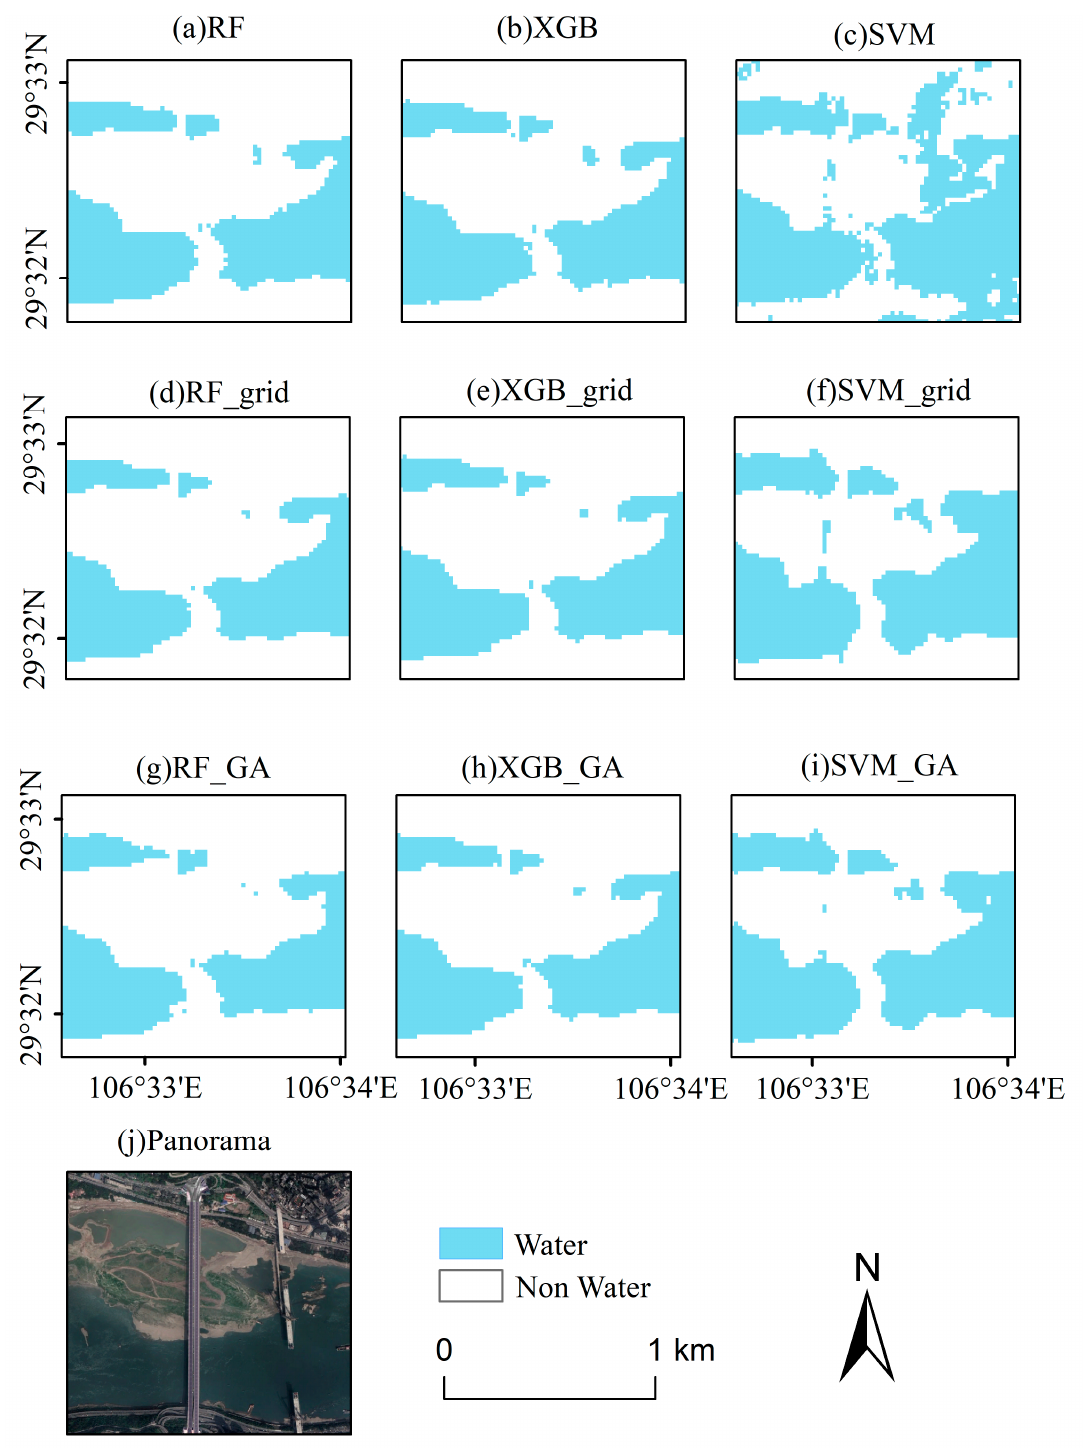
Figure 6. Maps of water surfaces produced by ( a ) RF, ( b ) XGB, ( c ) SVM, ( d ) RF optimized by grid search, ( e ) XGB optimized by grid search, ( f ) SVM optimized by grid search, ( g ) RF optimized by grid search, ( h ) XGB optimized by grid search, and ( i ) SVM optimized by grid search. ( j ) Panorama data of Shanhuba.